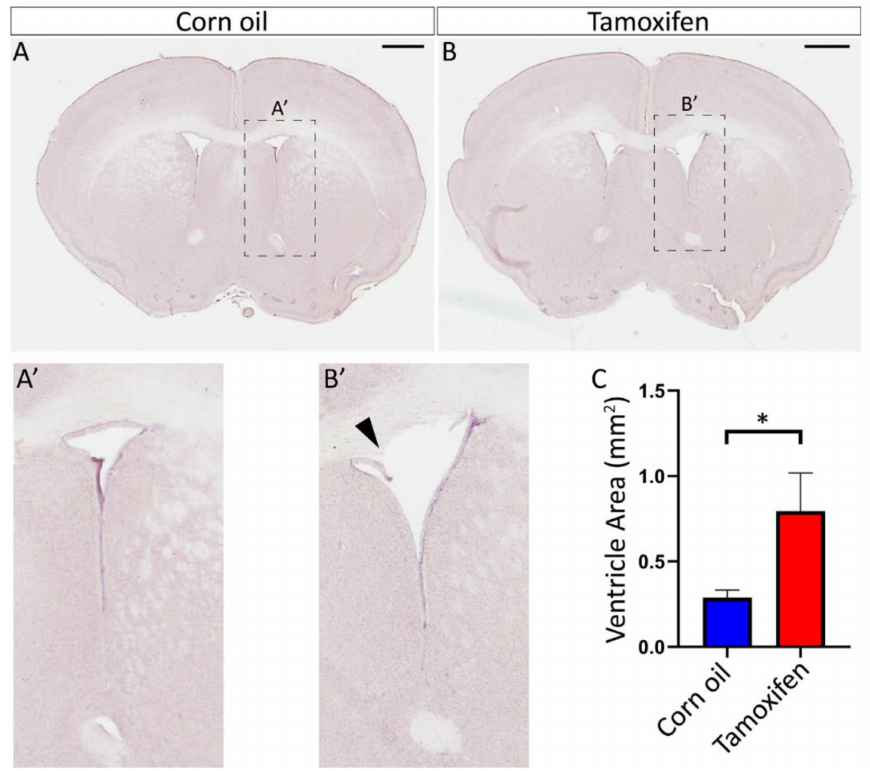
Figure 10. Tamoxifen treated Nfix Foxj1 − GFP mice have enlarged ventricles. ( A , B ) Depth matched sections of lateral ventricle tissue from Nfix iFOXJ − GFP mice treated with corn oil ( A ) and tamoxifen ( B ). ( A’ , B’ ) Dashed boxes ( A’ , B’ ) are enlarged in panels ( A’ , B’ ). ( B’ ) Sloughing of the ependyma occurs in the dorsal lateral ventricles of some tamoxifen treated Nfix iFOXJ − GFP mice (black arrowhead). ( C ) Measurements of ventricular area is displayed for tamoxifen treated Nfix iFOXJ1 − GFP mice and controls. Ventricle area is significantly increased in tamoxifen treated Nfix iFOXJ1 − GFP mice. * p < 0.05 two-tailed t -test. Graphs depict mean ± s.e.m. from seven samples per genotype. Scale bar ( A , B ) represents 1